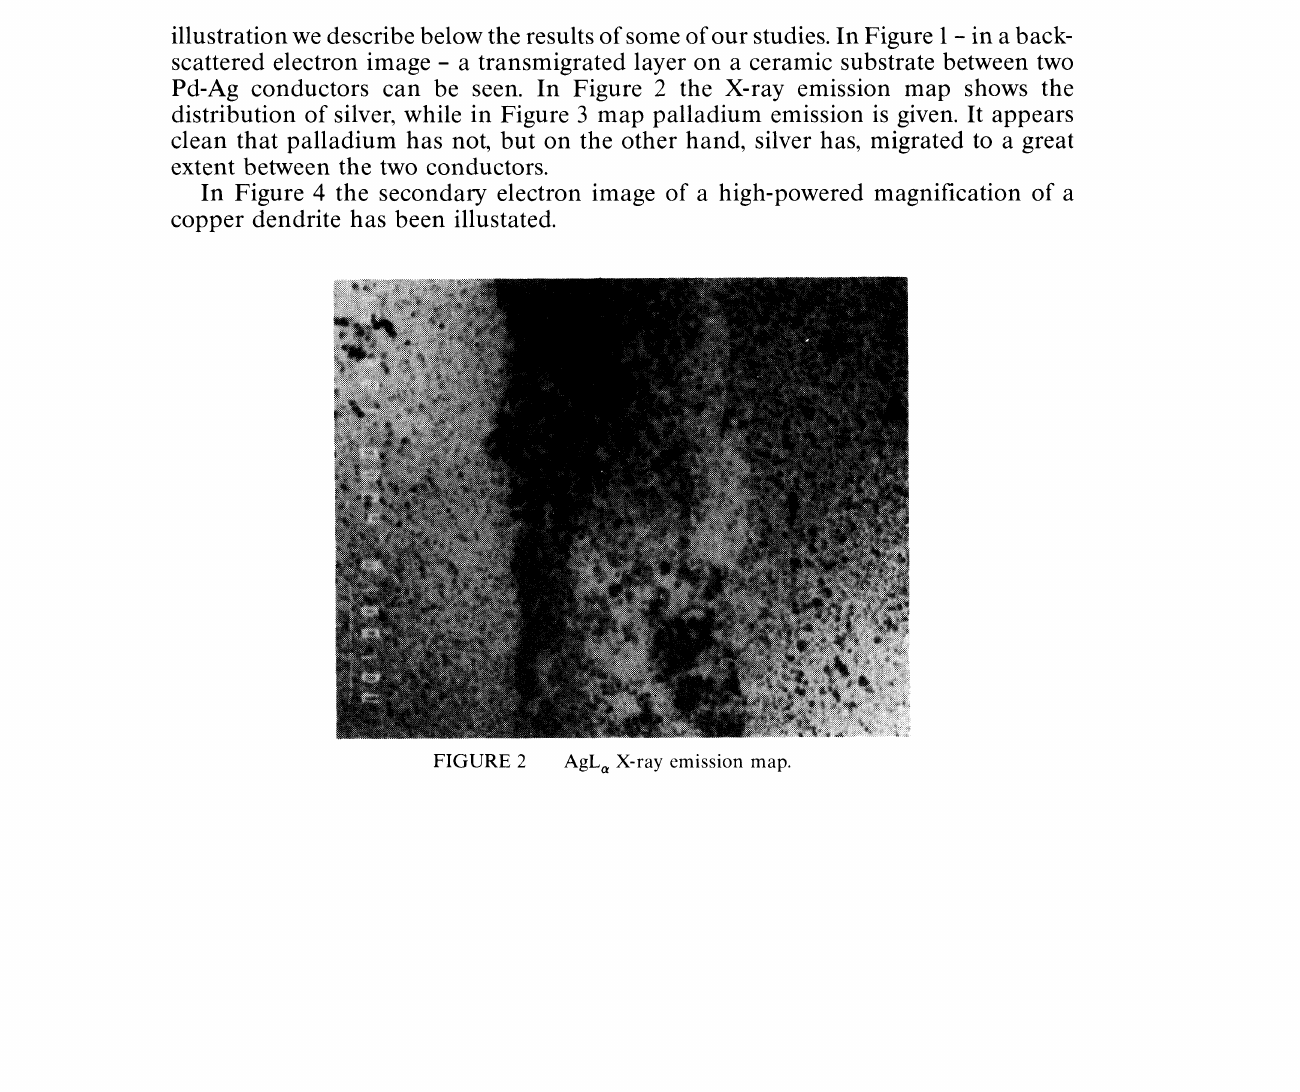
FIGURE Back-scattered electron image.